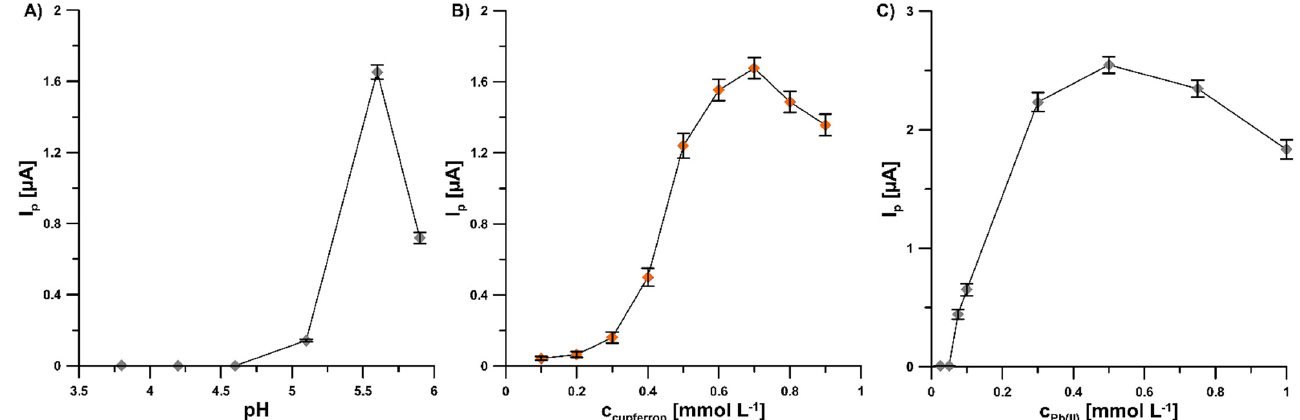
Figure 3. Dependence of V(V) peak current on: ( A ) pH buffer solution, cupferron ( B ), and Pb(II) ( C ) concentrations. Tested solution: 0.3 mol L − 1 buffer solution (CH 3 COONH 4 , CH 3 COOH, and NH 4 Cl) of pH 3.5, 4.2, 4.6, 5.2, 5.6, 5.9 ± 0.1 ( A ) or 5.6 ± 0.1 ( B , C ), 2.0 × 10 − 9 mol L − 1 V(V), 3.0 × 10 − 4 mol L − 1